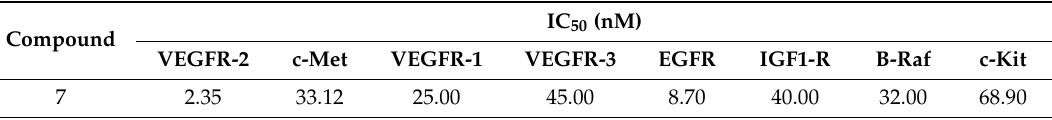
Table 2. RTKs selectivity profile of compound 7.